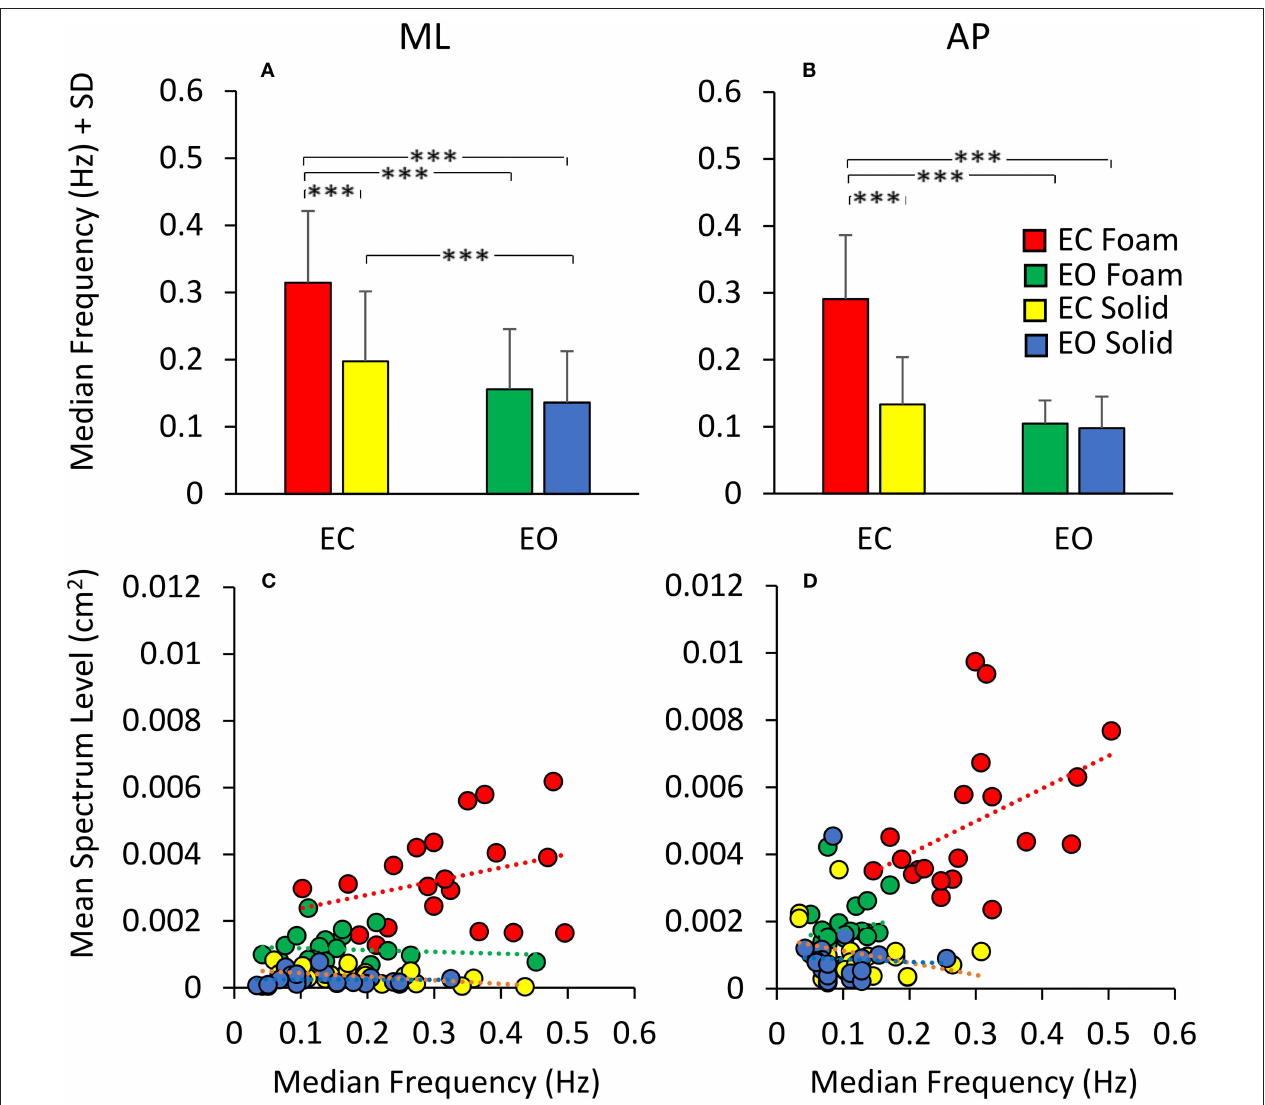
FIGURE 6 | Median Frequency and Spectrum Level. The mean Median Frequency (average of all subjects) is reported for both ML (A) and AP (B) directions, both visual and both support conditions (red, EC Foam; green, EO Foam; yellow, EC Solid; blue, EO Solid). With Foam, the Median Frequency is higher than with Solid support for both ML and AP directions. With EO, the Median Frequency is smaller than that with EC, especially with Foam, for both ML and AP directions. The relationship between mean Spectrum Level and Median Frequency is reported in the lower panels for both ML (C) and AP (D) directions, both visual and both support conditions. Each dot corresponds to a subject. The Spectrum Level is not related to the value of the Median Frequency, both in ML and AP directions and with both visual and support conditions. Asterisks indicate significant differences (*** p <